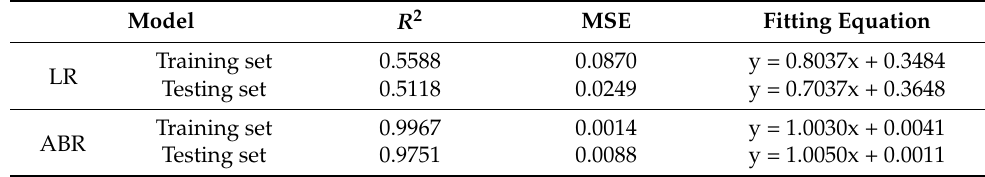
Figure 9. IRI predicted and measured values: ( a ) LR model on the training set, ( b ) LR model on the testing set, ( c ) ABR model on the training set, and ( d ) ABR model on the testing set. Table 4. Performance comparison of LR and